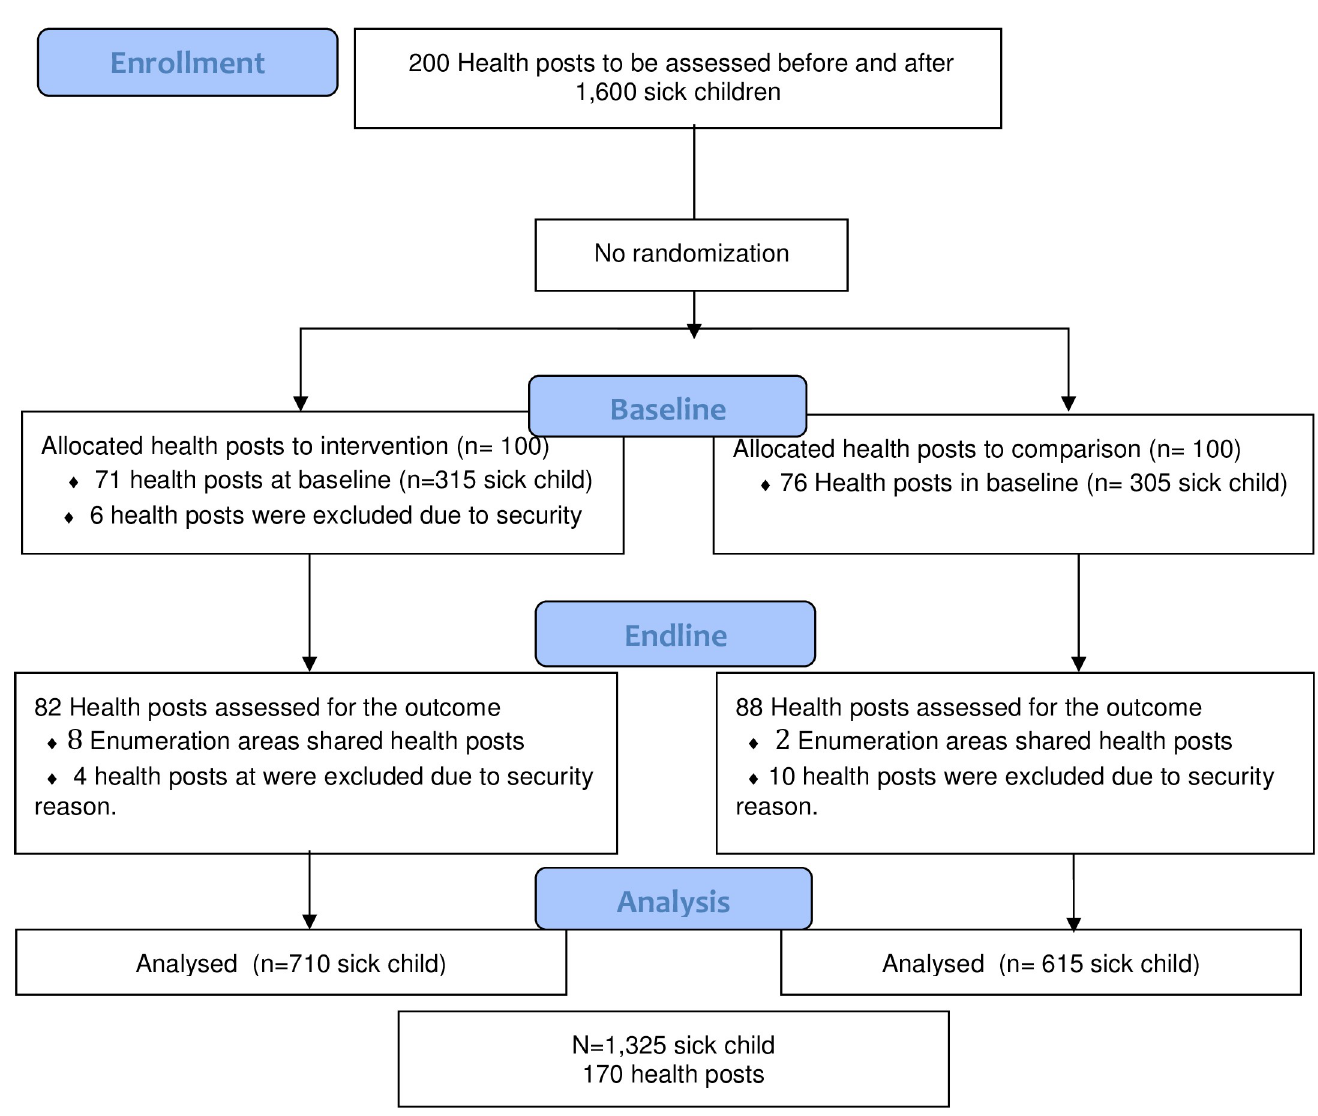
Fig 1. Study flow diagram of intervention and comparison areas by baseline and endline data collection